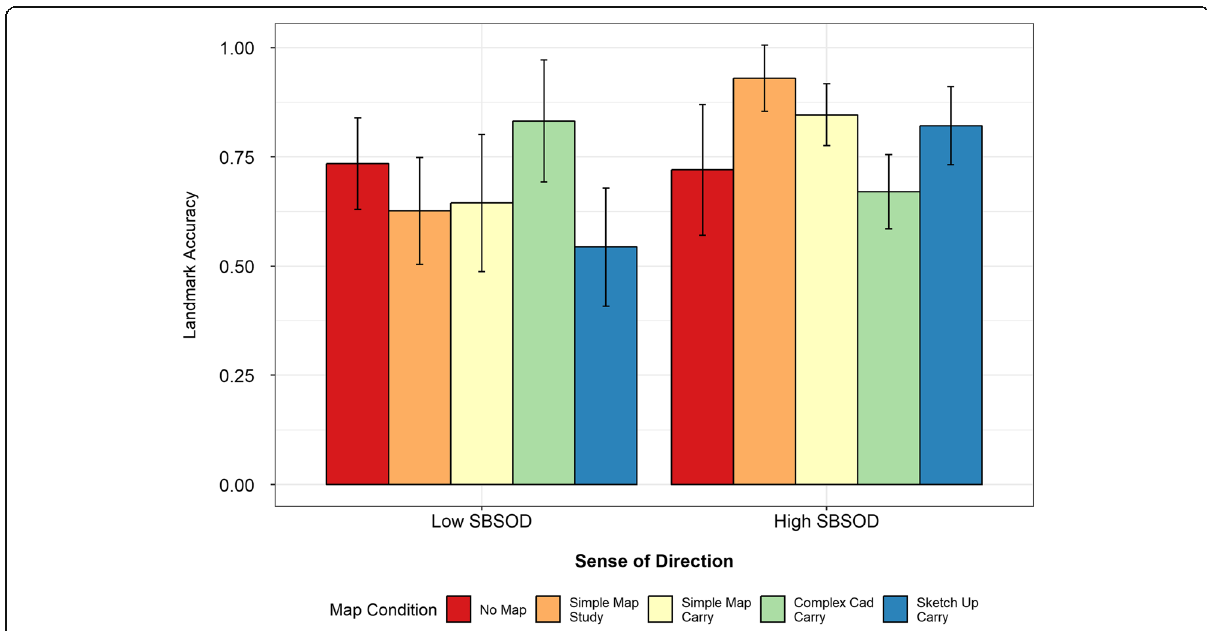
Fig. 12 Map completion task landmark accuracy scores as a function of map condition, split by sense of